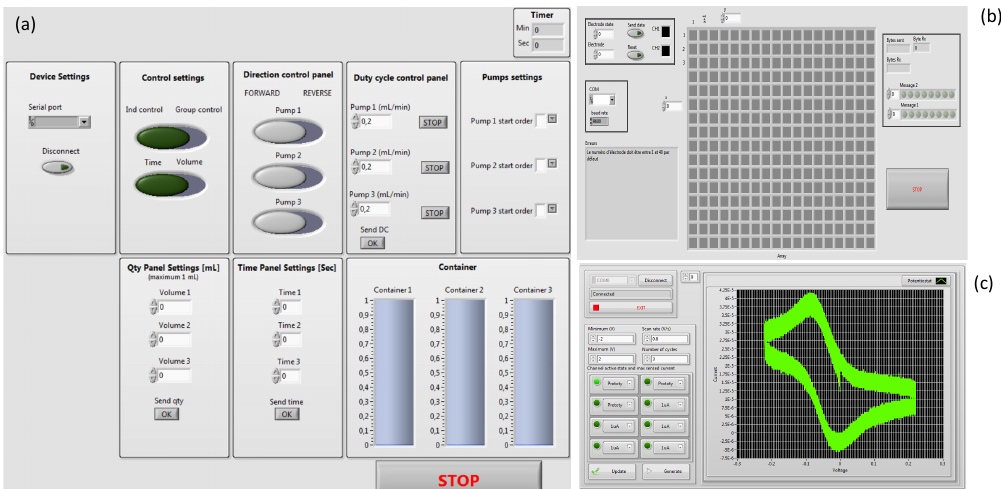
Figure S4. Designed LabVIEW interface (a) micro-pump control (b) electrode array control Figure 8. Designed LabVIEW interface ( a ) micro-pump control ( b ) electrode array control and and (c) 3-channel potentiostat interface. ( c ) 3-channel potentiostat interface.